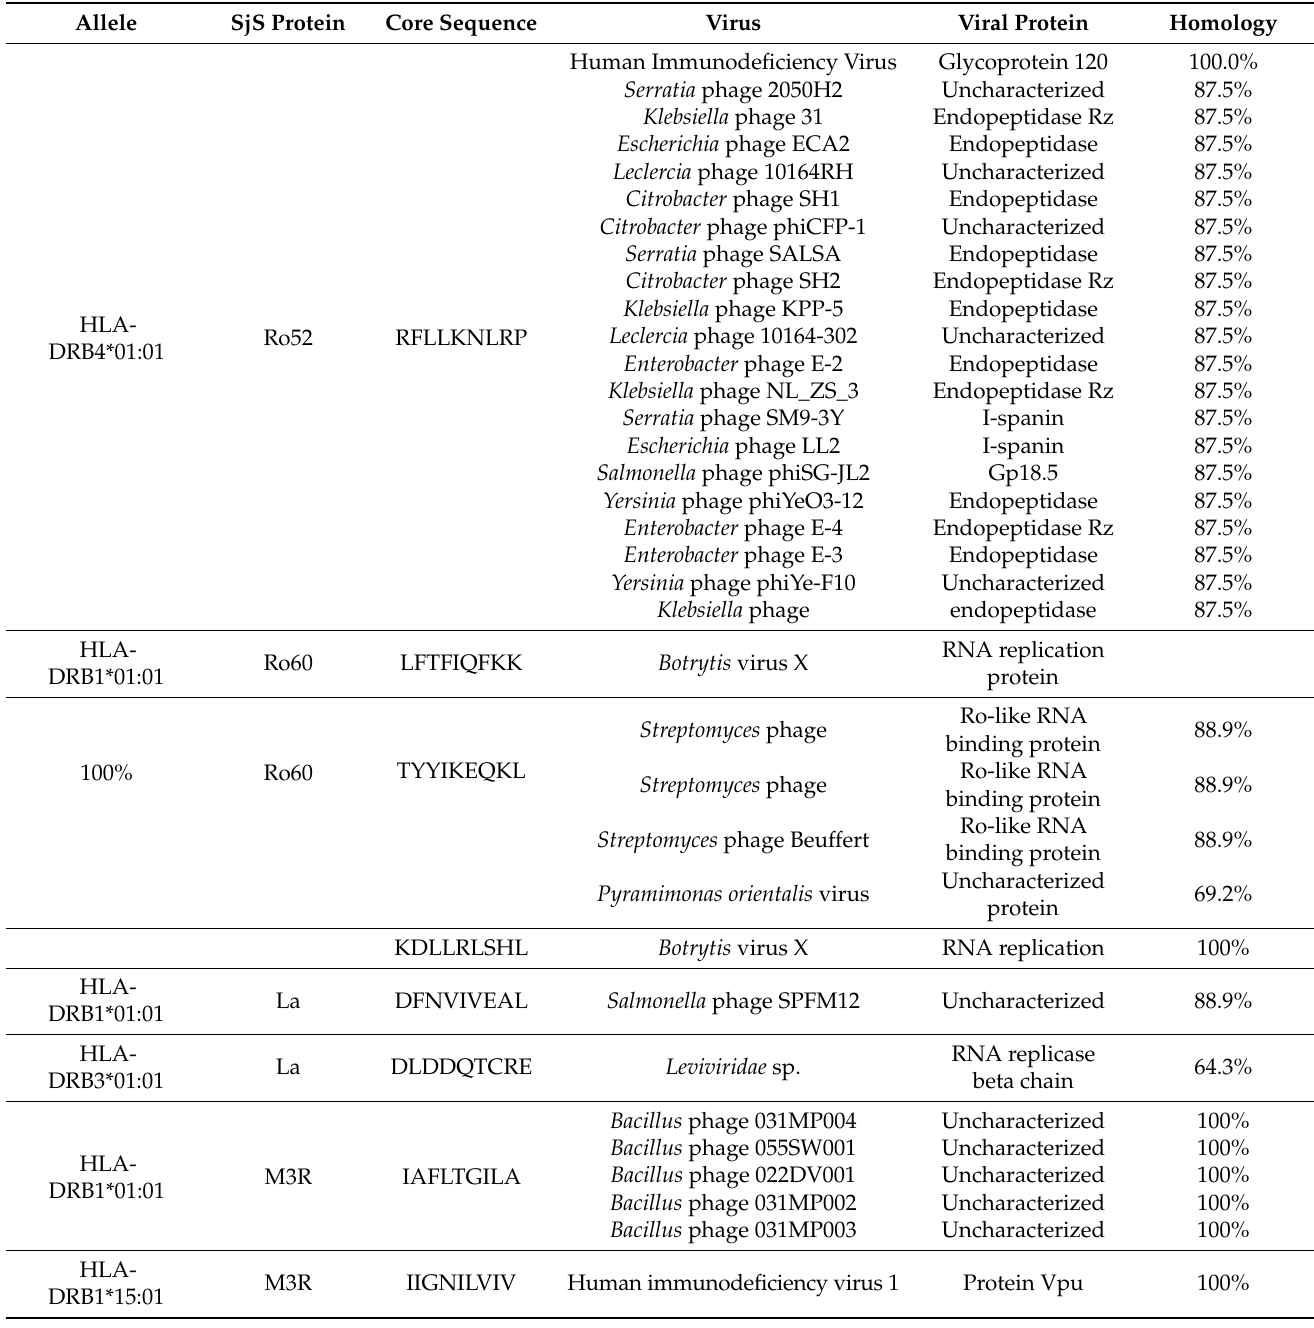
Table 16. Homology of predicted peptides binding to HLA alleles to viral